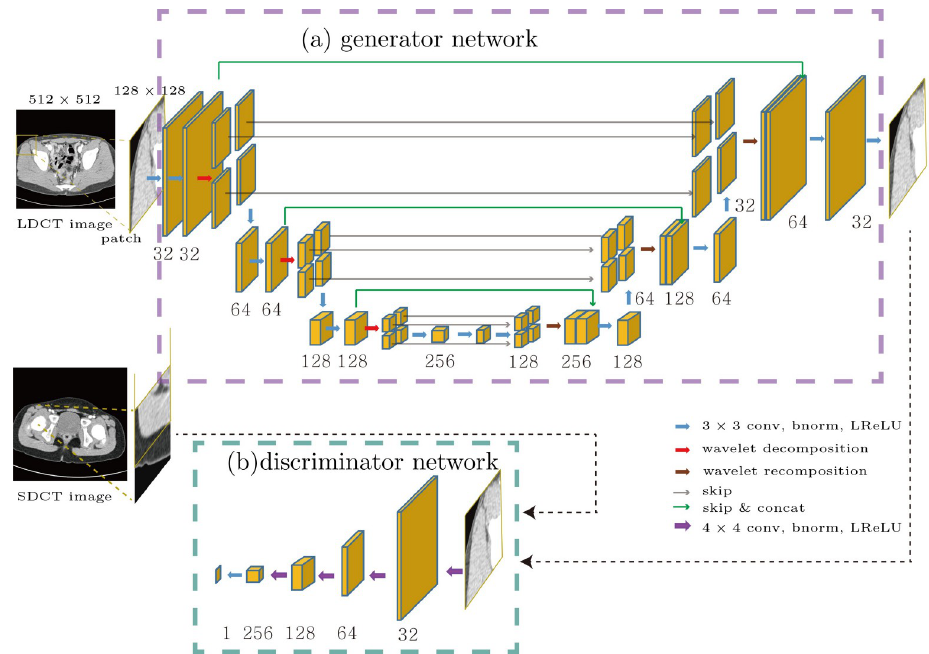
Fig 3. Network architectures of the VIGAN: generator (a) and discriminator (b). The number below the yellow box denotes the number of features used for training. VIGAN = generative adversarial network for virtual standard dose CT image generation. bnorm = batch normalization, conv = convolution, LReLU = leaky rectified linear unit, concat = concatenation.